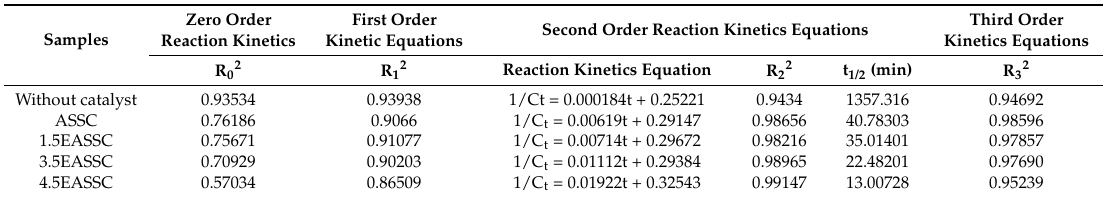
Figure 6. The relationship of photocatalytic degradation of basic violet 5BN dye pollutant and electrical conductivity: ( a ) Degradation; and ( b ) both degradation and electrical conductivity. The reaction kinetics equations and relative parameters for photocatalytic degradation of basic violet 5BN dye are summarized in Table 3. The correlation coefficients of R 02 , R 12 , R 22 , and R 32 corresponding to the zero, first, second, and third order kinetics equations. The correlation parameter is in the order of R 22 > R 32 > R 12 > R 02 , respectively, implying that the photocatalytic degradation of basic violet 5BN dye belongs to the second order kinetics. The 4.5EASSC catalyst displays the best correlation of 0.99147 and the smallest half-life of 13.01 min in Table 3. Table 3. Parameters of kinetic equations for photocatalytic degradation of basic violet 5BN dye pollutant.